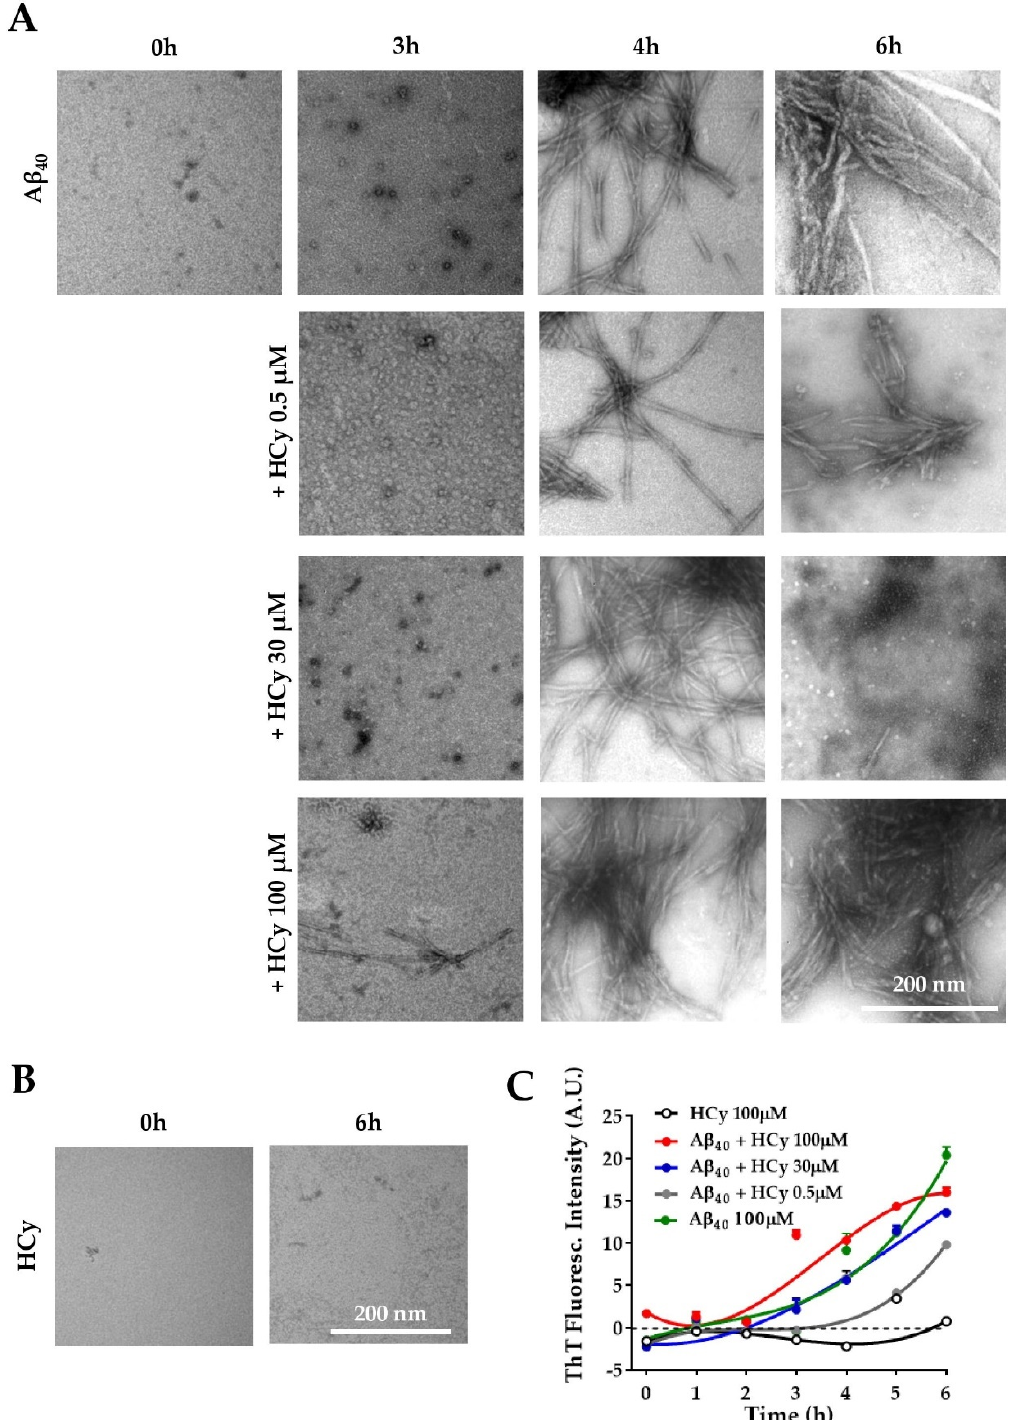
Figure 4. Differential effects of HCy on Aβ aggregation. ( A ) Electron microscopy of Aβ 40 peptide added in the absence of HCy or after 3, 4, or 6 h of aggregation with different concentrations of HCy. ( B ) Representative electron microscopy images showing no aggregation of 100 µM HCy alone after 6 h. ( C ) The Aβ 40 peptide aggregation curve followed by a Thioflavine-T (Th-T) fluorescence assay in the presence or absence of different concentrations of HCy. Curves were subjected to a robust fit using a third-order polynomial equation, with a goodness of fit RSDR of 1.11 for Aβ 100 µM, 0.66 for Aβ + HCy 0.5 µM, 1.89 for Aβ + HCy 30 µM, 1.60 for Aβ + 100 µM, and 0.56 for HCy 100 µM.